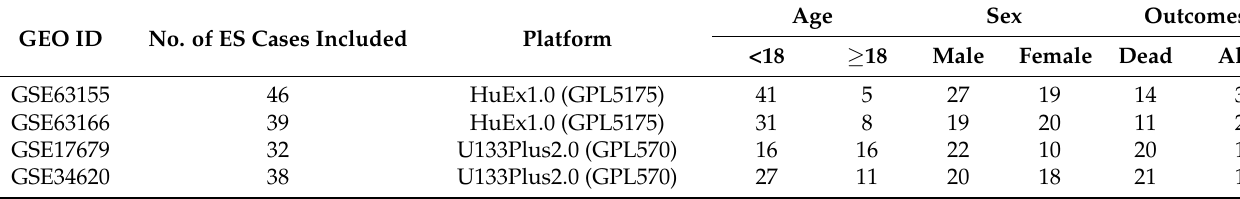
Table 1. GEO datasets and patient characteristics of